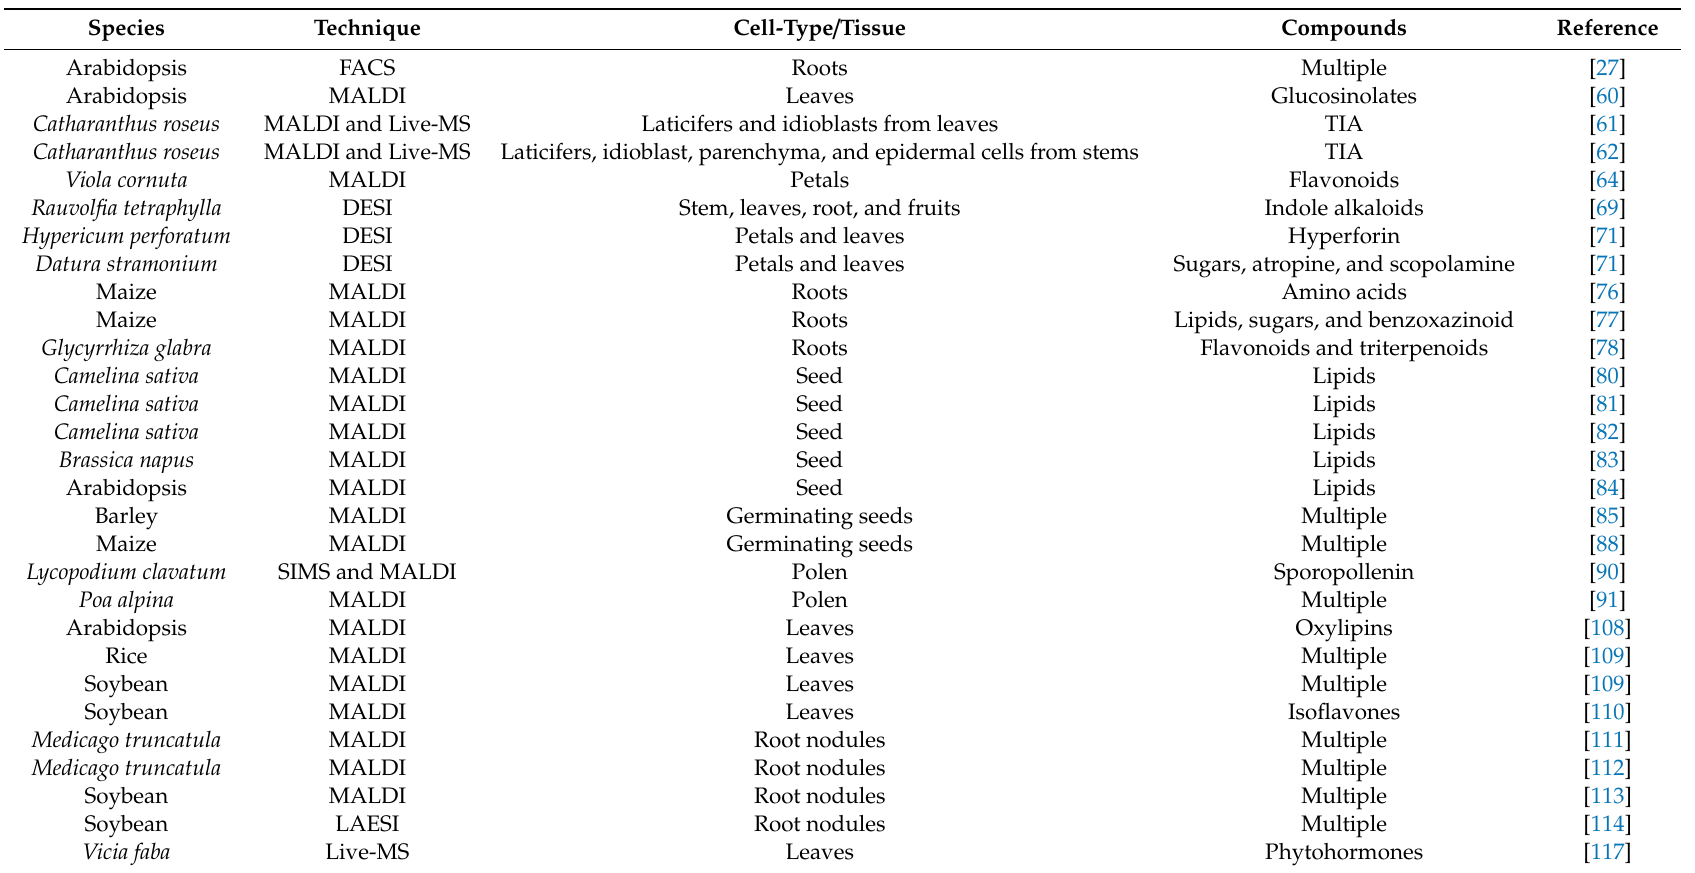
Table 1. Summary of spatially resolved plant metabolomics works applying mass spectrometry-based platforms described in this